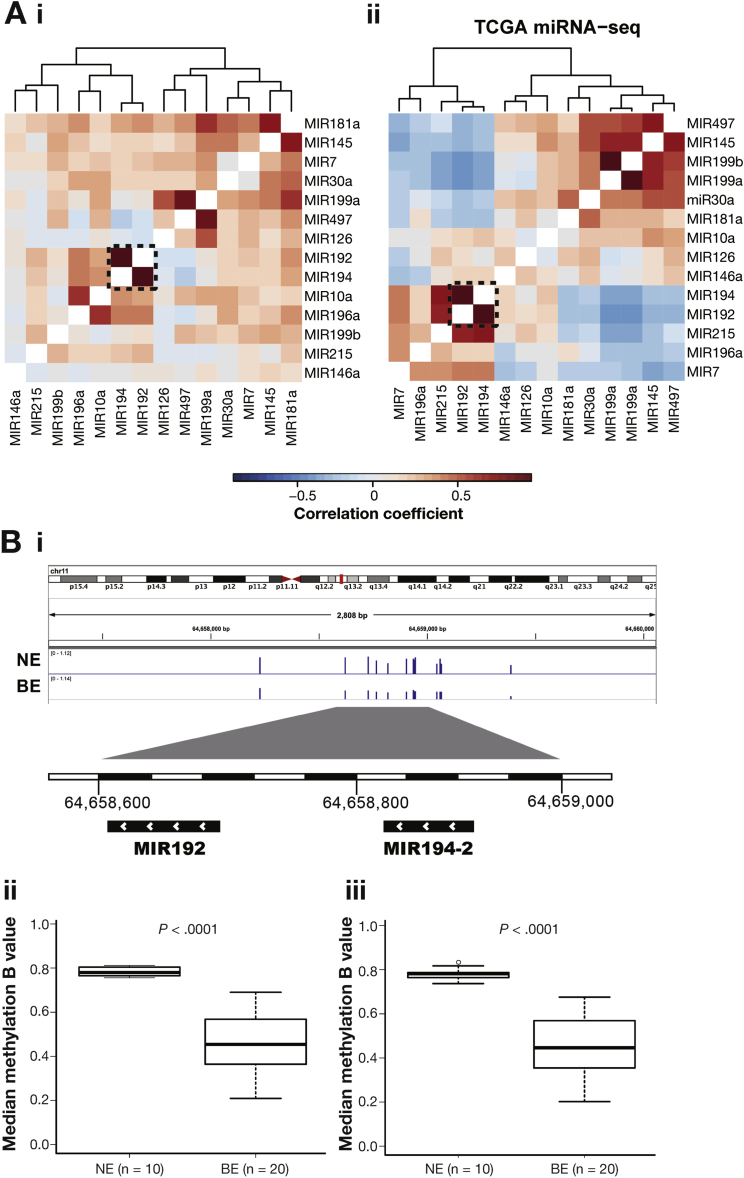
Coexpression of MIR192/194 and hypomethylation found in the promotor region of miRNA cluster MIR192-194-2. (A) Heatmap showing the Pearson correlation coefficient (color key) between 15 consensus up-regulated miRNA expressions based on validation data from this study (A i) and TCGA esophageal adenocarcinoma miRNA sequencing data (A ii). Dendrograms show the hierarchical clustering based on the complete linkage method and Euclidean pairwise distance. Genomic region of cluster MIR192-194-2 shows DNA methylation probe peaks in the promoter region (<1 kb) in NE and BE samples (B i). Median methylation beta values were plotted for MIR192 and MIR194–2 (B ii). Significance was determined by Mann-Whitney test.